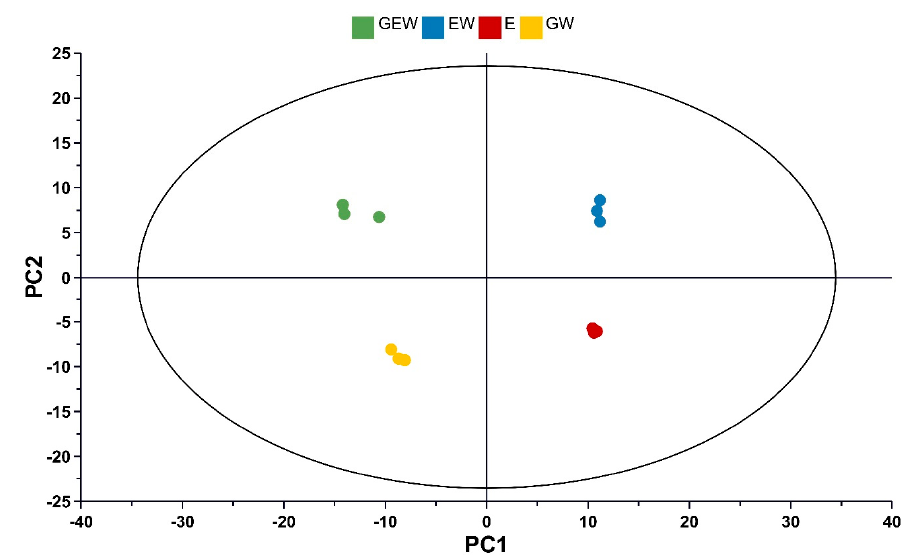
Figure 2. PCA scores plot of QGP extracts. E = ethanol, EW = ethanol/water, GEW = glycerol/ethanol/water, and GW = glycerol/water. Extracts are coloured by their respective groups ( n = 3) and sized by their DCrit value. DCrit is a unitless value that represents a limit for potential outlier identification. Identical sizing of all circles indicates no potential model outliers and standard variation between replicates. Four significant PCs were generated for this model where the following variance has been explained; PC1: 46.1%, PC2: 21.6%, PC3: 13.4%, PC4: 8.0%, and R 2 cumulative: 89%. QGP extracts generated using glycerol as a solvent separate along PC1 from ethanolic extracts. GW and EW separate from GW and E along PC2. GW separates along PC1 and PC2 from EW indicating significant group differences. Separate grouping of extraction solvents into the centre of each quadrant demonstrates ‘like’ variance between groups and even distribution within the model space. Q 2 cumulative = 66.7% indicates good predictability of the PCA model.